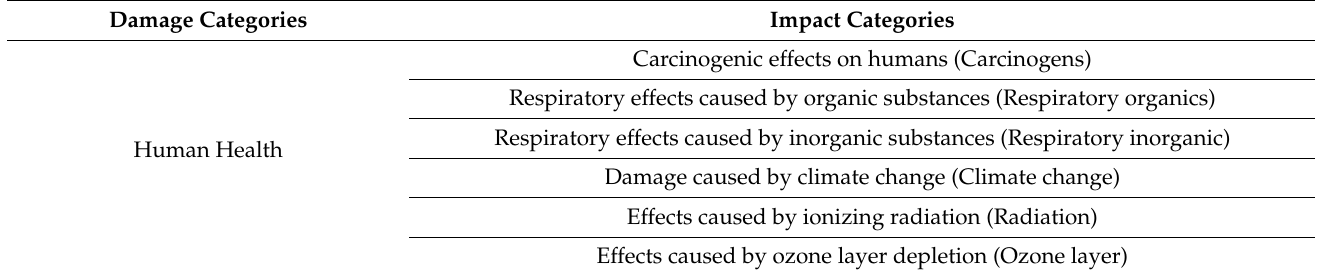
Table 2. Damage categories and impact